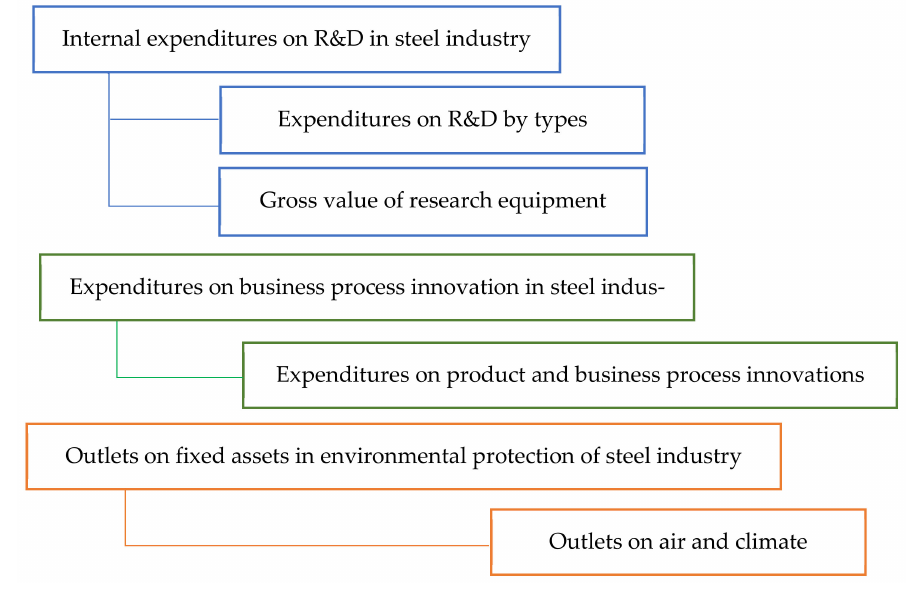
Figure 1. R&D&I activities in the analysis. Source: own